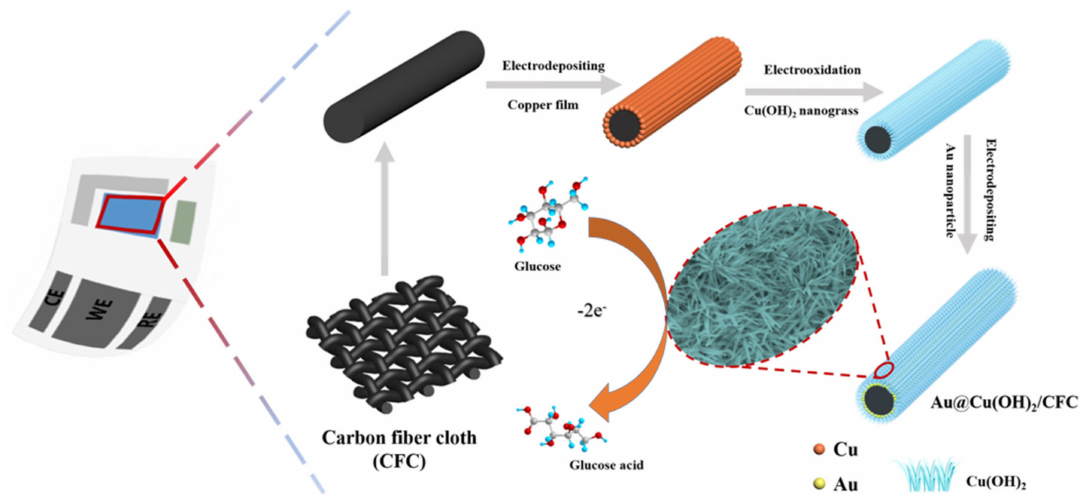
Figure 1. Schematic illustration of the fabrication process for the Au nanoparticle modified copper hydroxide nanograss arrays on flexible carbon fiber cloth (Au@Cu(OH) 2 / CFC) electrode and the corresponding detection